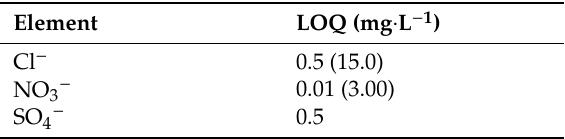
Table 2. Limits of Quantification (LOQ) of the measurement anions by HPLC.